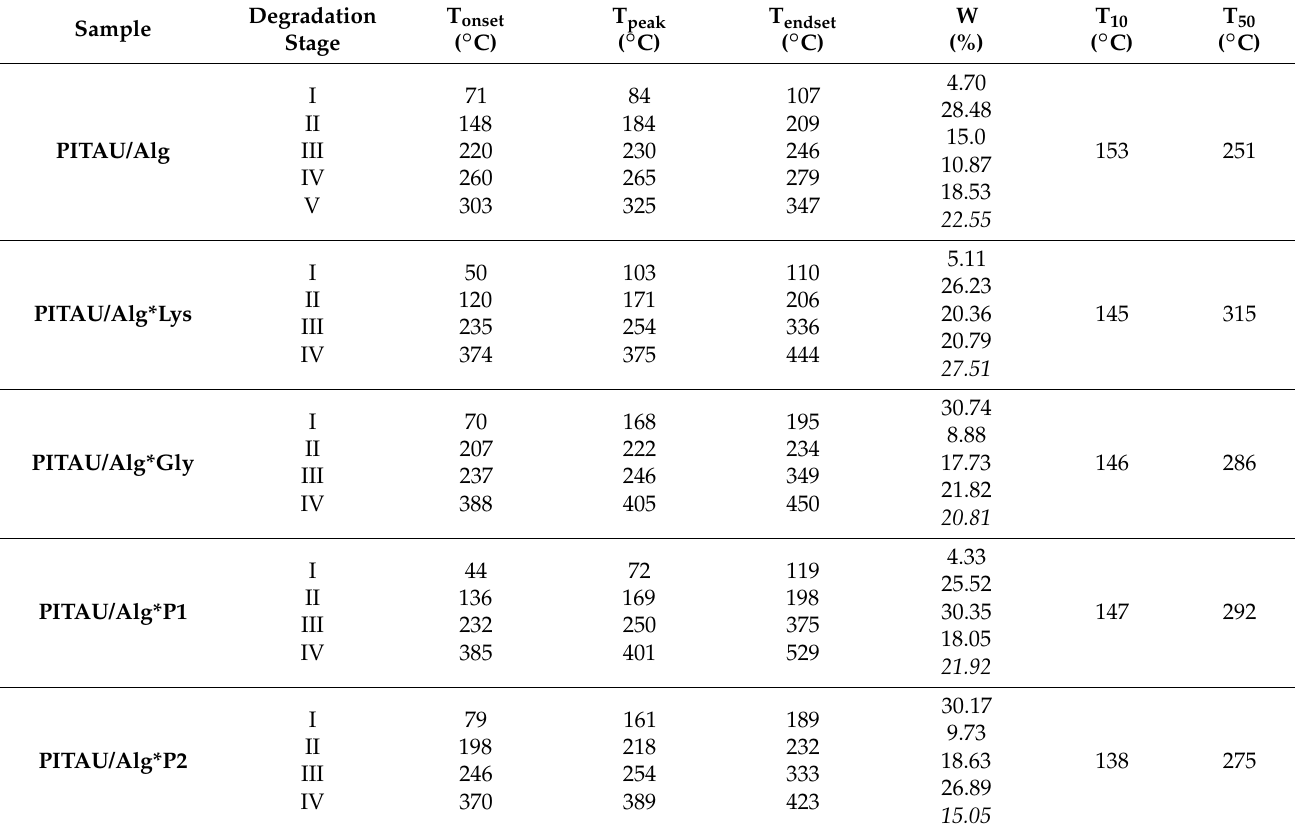
Table 2. The main thermal parameters obtained by thermal degradation of